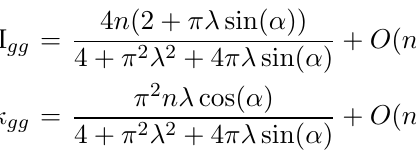
Figure 4 . A plot of (cid:1)(cid:5) = (cid:5) ff (cid:0) 2 n in the large n and (cid:28) limit with (cid:21) = n= j (cid:28) j (cid:12)xed. From top to bottom on the right, the curves correspond to (cid:11) = 0, (cid:25) q 2 (cid:11) = 0 occurs when (cid:21) = and (cid:1)(cid:5) = (cid:0) (cid:25) 2 . The minimum at (cid:11) = (cid:25) 32 (cid:0) (cid:25) 2 32 (cid:16) (cid:17) 2 (cid:25) 2 (cid:0) 16 ; (cid:0) ( (cid:25) 2 (cid:0) 8) 2 (cid:25) (24 (cid:0) (cid:25) 2 ) 16 (cid:25) 2